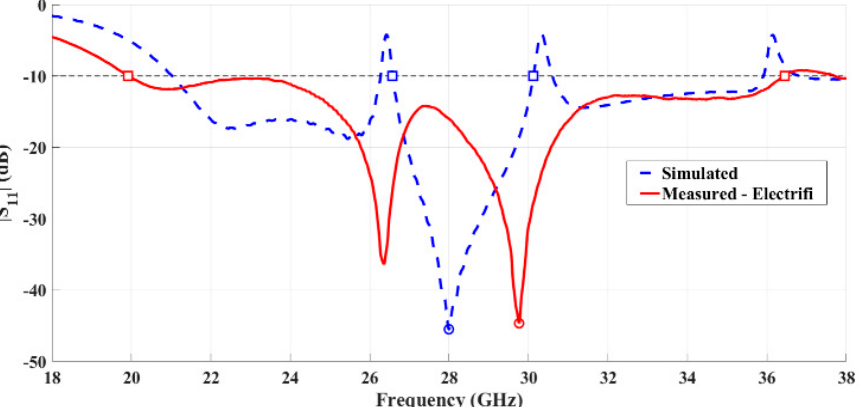
Figure 12. Comparison between simulated and measured reflection coefficient of the fabricated horn antenna using conductive filament.